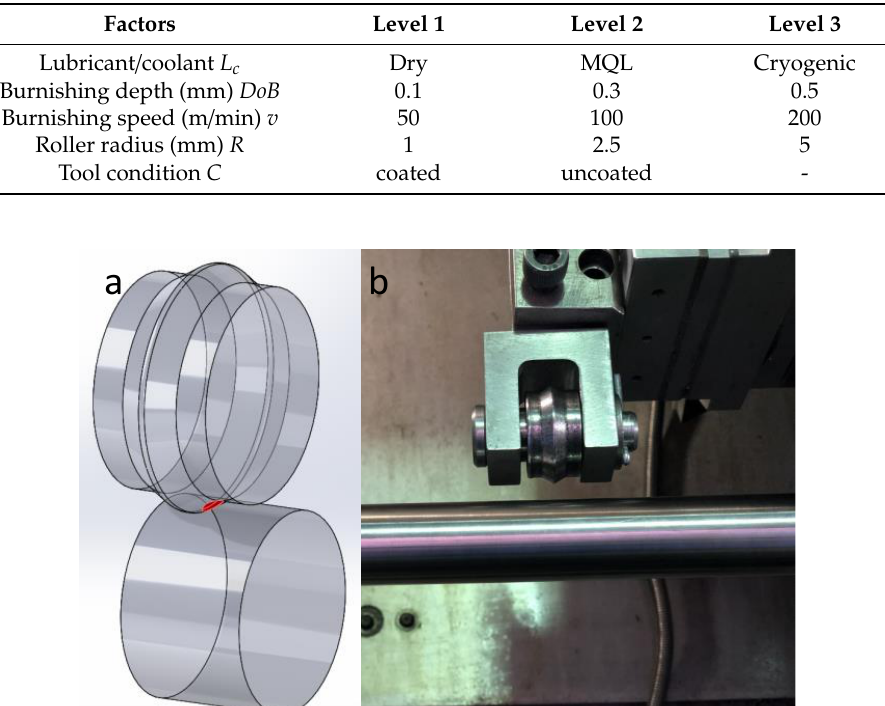
Figure 1. Tool design ( a ) and burnishing setup ( b ) for the experimental campaign. Table 1. Design of experiments for burnishing Ti-6Al-4V alloy.